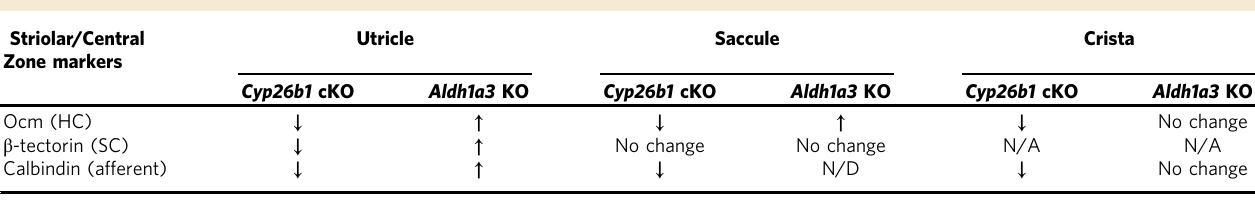
N/A not available N/D not